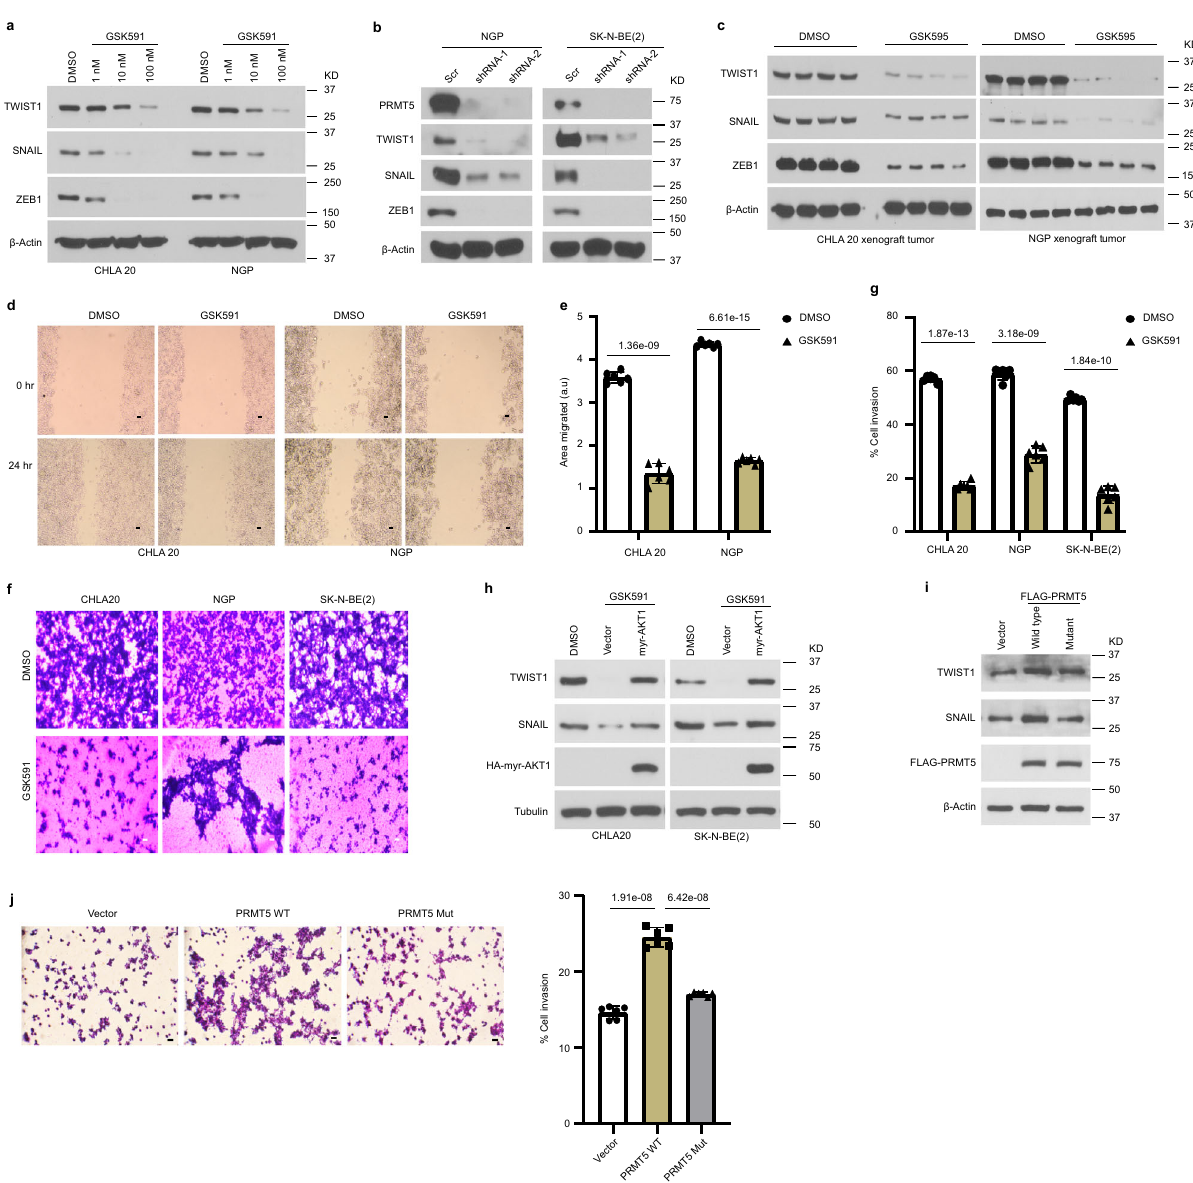
Fig. 6 PRMT5/AKT regulates the EMT program. a Immunoblots showing the expression of TWIST1, SNAIL, and ZEB1 in neuroblastoma cells treated with DMSO or increasing doses of GSK591 in CHLA20 and NGP cells. b Analysis of TWIST1, SNAIL, and ZEB1 protein levels in the scramble and shPRMT5 cells. c The expression of EMT transcription factor TWIST1, SNAIL, and ZEB1 was examined in xenograft tumors from mice treated with vehicle or GSK595 ( n = 4). d Representative images of DMSO or GSK591-treated cells migrated to the cleared space (wound) after 24 h. Scale bars, 100 μ m. e Quanti fi cation of in vitro cell migration assay ( n = 6). The migration area was determined by measuring the total area of the wound using the ImageJ software. f Representative images of DMSO or GSK591-treated cells invaded to ECM coated membrane in transwell invasion assay. Scale bars, 100 μ m. g Percentage of invasive cells normalized by cell numbers in the non-ECM coated 12-well plate using ImageJ ( n = 6). h Protein levels of TWIST1 and SNAIL were analyzed in DMSO or GSK591-treated cells transfected with a vector or constitutively activated AKT1. i The protein levels of TWIST1 and SNAIL in cells overexpressing PRMT5 wild type or enzyme activity de fi cient mutant by Western blotting. j Representative images of CHLA20 cells overexpressing vector, wild type PRMT5, or an enzymatic de fi cient form of PRMT5 invaded to ECM coated membrane in the transwell invasion assay (left). Scale bars, 100 μ m. Percentage of invasive cells normalized by cell numbers in the non-ECM coated 12-well plate using ImageJ ( n = 6) (right). e , g p values were calculated by two-tailed unpaired Student ’ s t -test using Microsoft Excel. j p values were determined using one-way ANOVA with Tukey ’ s multiple comparisons test. Error bars represent SD. a , b , d – j Representative results from three independent experiments and the results shown are from a representative experiment. Uncropped immunoblots are provided in the Source Data fi